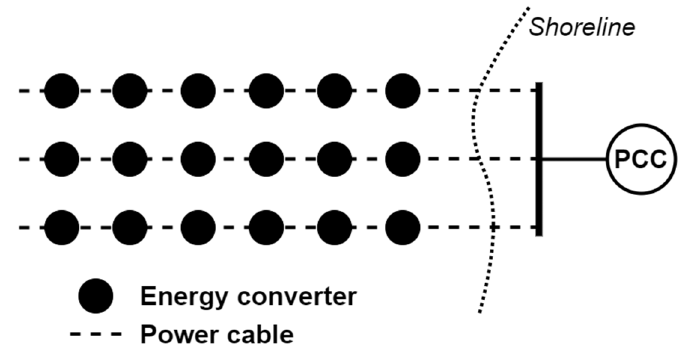
Figure 1. Radial